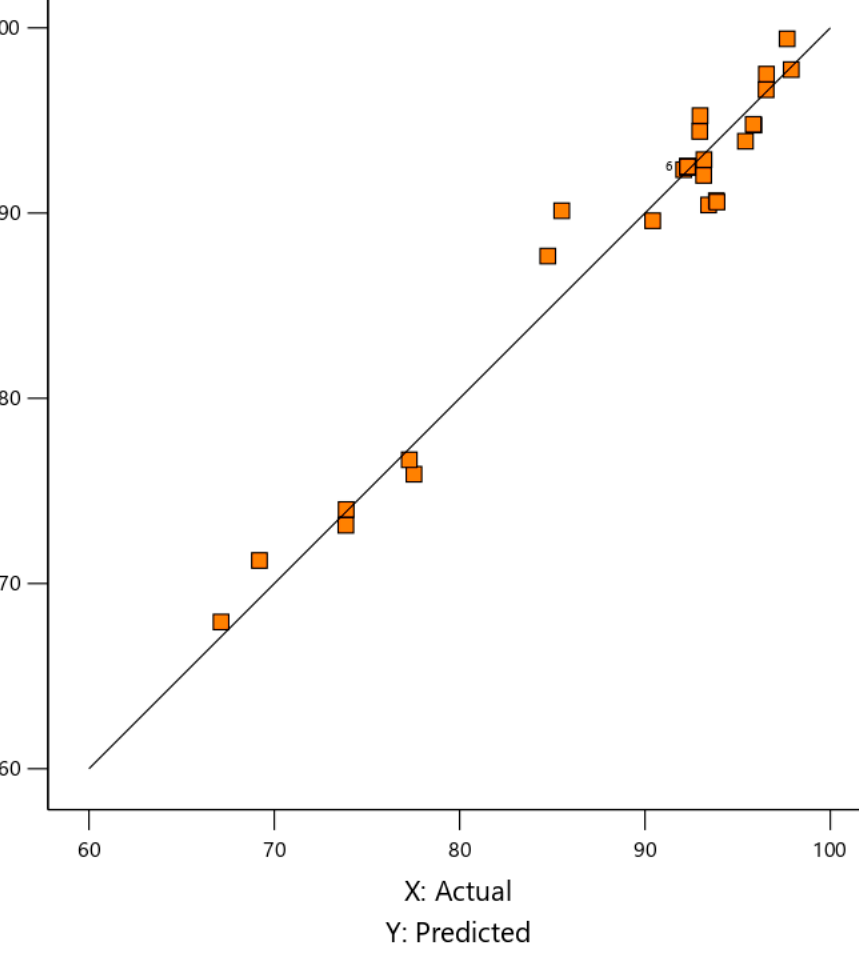
Figure 4. Relationship between biodiesel yield predictions and experimental data .